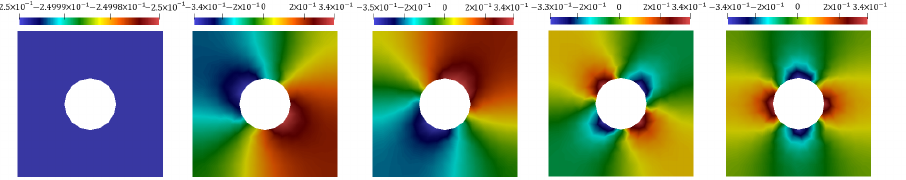
Figure 5. Illustration of the perforation boundary multiscale basis functions for Laplace problem, ψ i for k = 1, . . . ,5 (from left to right p , k